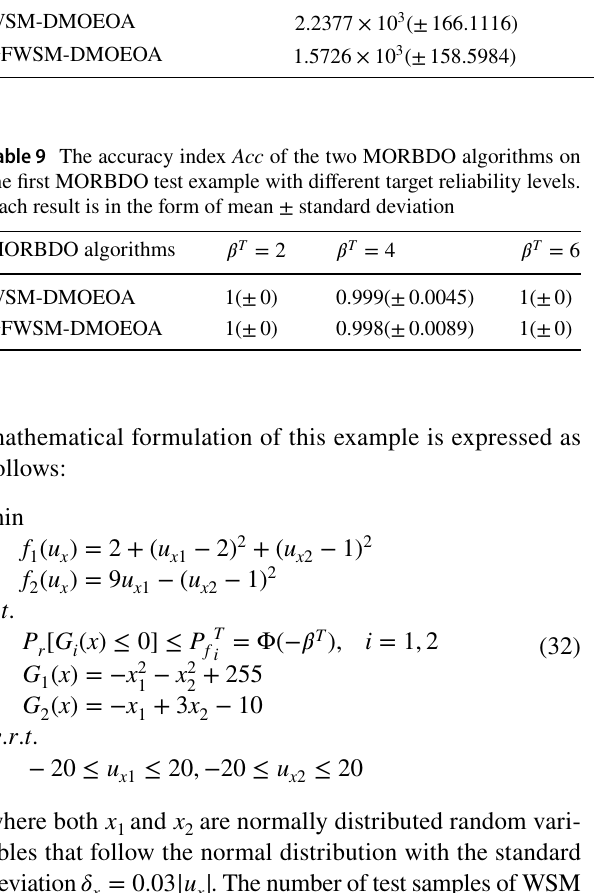
Table 8 The computational time (s) of the two MORBDO algorithms on the first MORBDO test example with different target reliability levels. Each result is in the form of mean ± standard deviation MORBDO algorithms